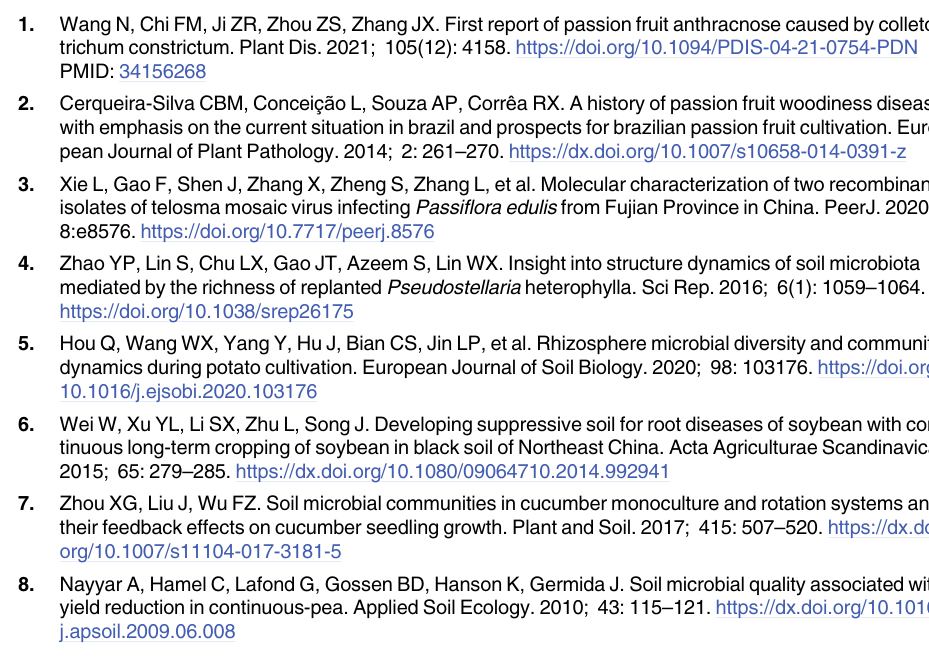
S10 Table. The analysis of different metabolic pathways between RY and NCS for bacteria. (XLS) S11 Table. The analysis of different metabolic pathways between CS and NCS for bacteria. (XLS) S1 Fig. Analysis of overall secondary function for fungi (a) and bacteria (b). The abscissa and ordinate represent the average abundance and different functional pathways at the second level and the first level of pathway classification is shown on the right